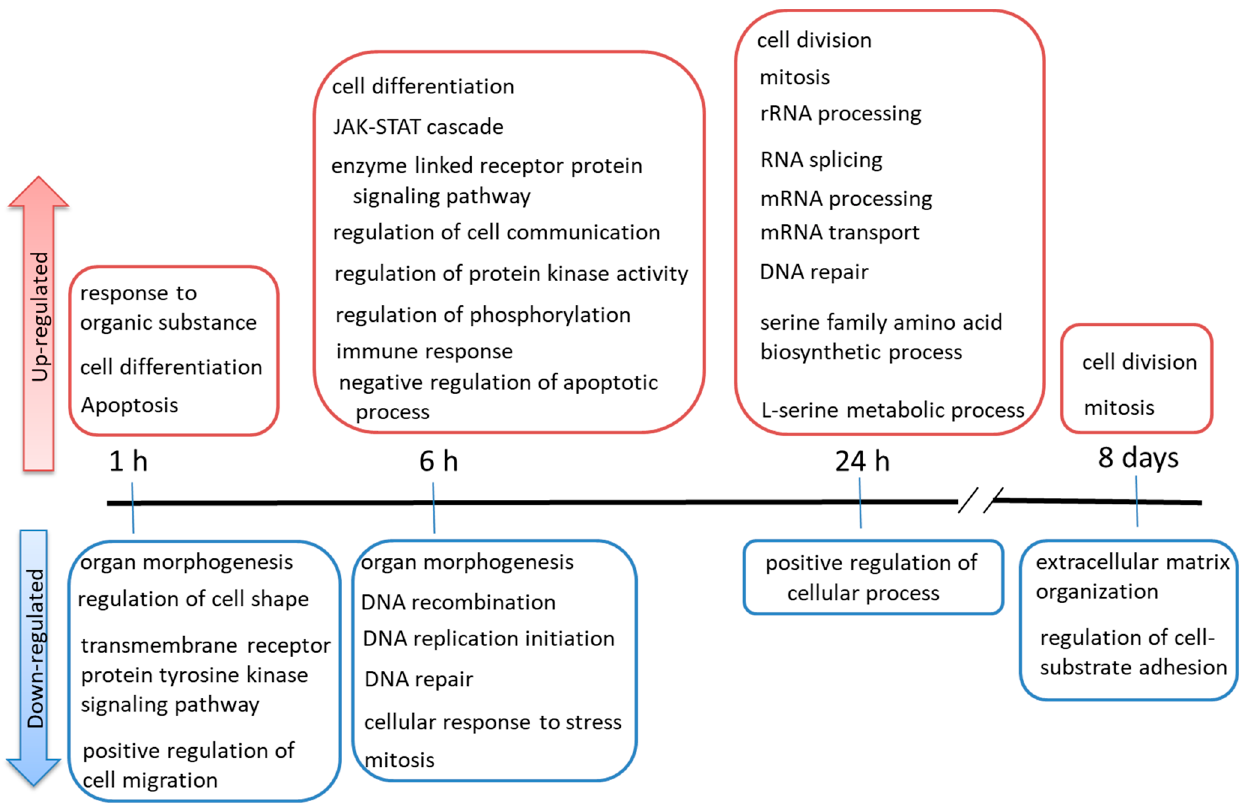
Figure 3. Gene Ontology terms for selected genes. The GO terms up-regulated due to TPA treatment for ( A ) 1 h and 6 h. Gene Ontology terms for selected genes (continued). The GO terms up-regulated due to TPA treatment for ( B ) 24 h and 8 days.